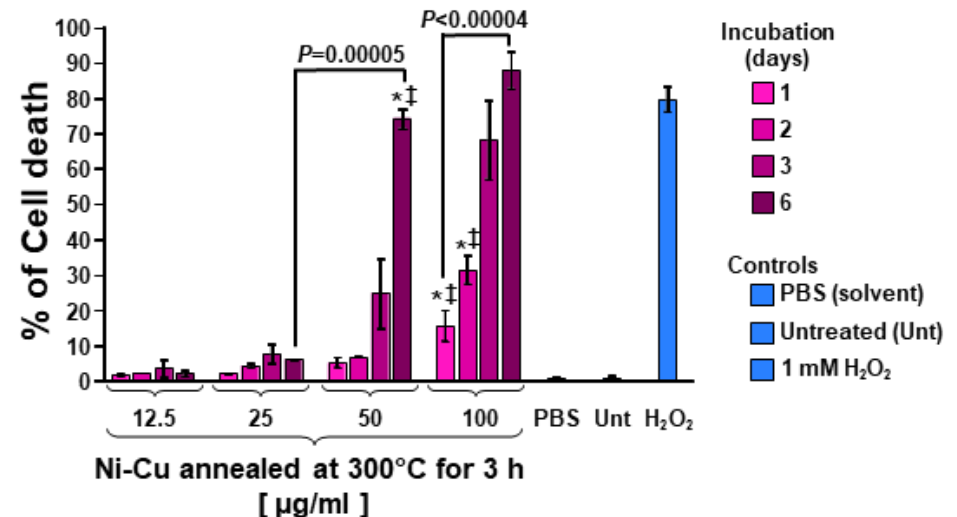
Figure 5. Ni-Cu magnetic nanoparticles inflict cytotoxicity on human breast MDA-MB231 cells in a dose-dependent manner. These nanoparticles displayed a size of 53 nm and were annealed at 300 °C for 3 h. Cells were incubated for 1, 2, 3, and 6 days with a nanoparticle concentration gradient (in μg/mL). Cellular cytotoxicity ( y -axis) was quantified by using the differential nuclear staining assay (DNS: Hoechst and propidium iodide (PI)) and a bioimager system. PBS-treated (1% v/v) cells were used as a solvent control. Untreated (Unt) cells were included as a negative control. In contrast, cells exposed for 24 h to 1 mM of H 2 O 2 were incorporated as a positive control for cytotoxicity. Data acquisition and analyses were accomplished via IN Cell Analyzer Workstation 3.2 software (GE Healthcare). When comparing an experimental sample with PBS-treated (*) or untreated cells (‡), the P -values were both <0.05.